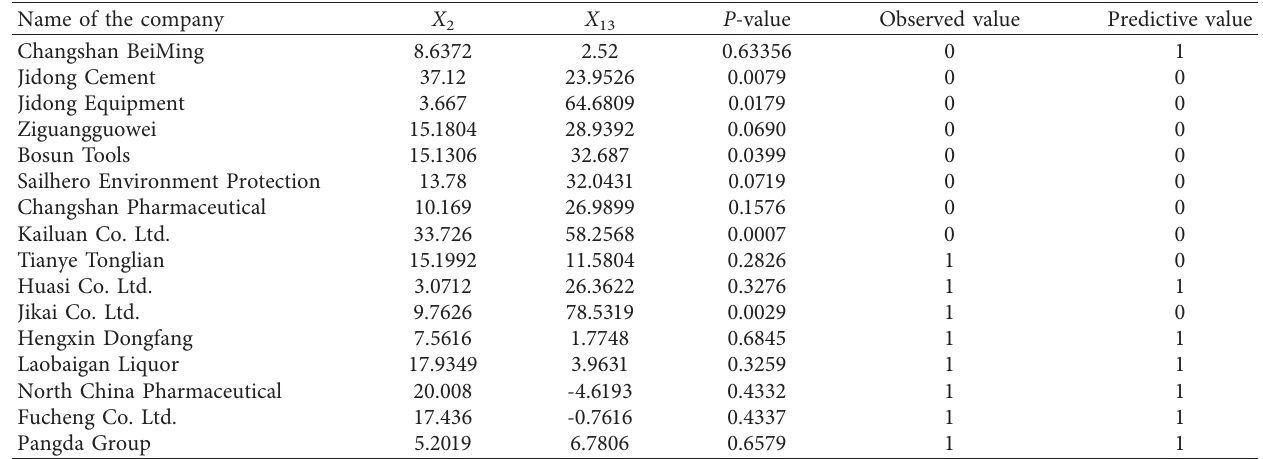
Table 7: Results of logistic model data test.